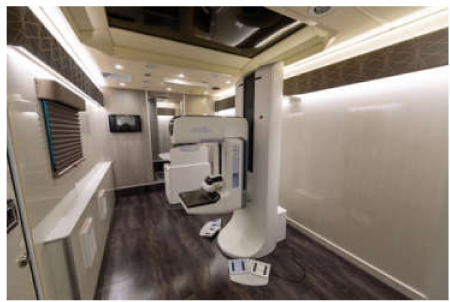
Figure 2. Interior of a mobile mammography van, with a mammography unit seen